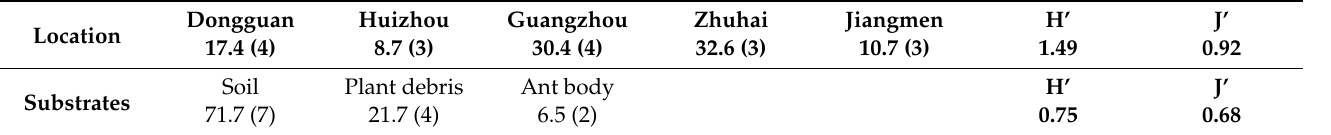
Table 3. Fungal taxa abundance, evenness, richness of species, and diversity index across sampling locations and substrates.